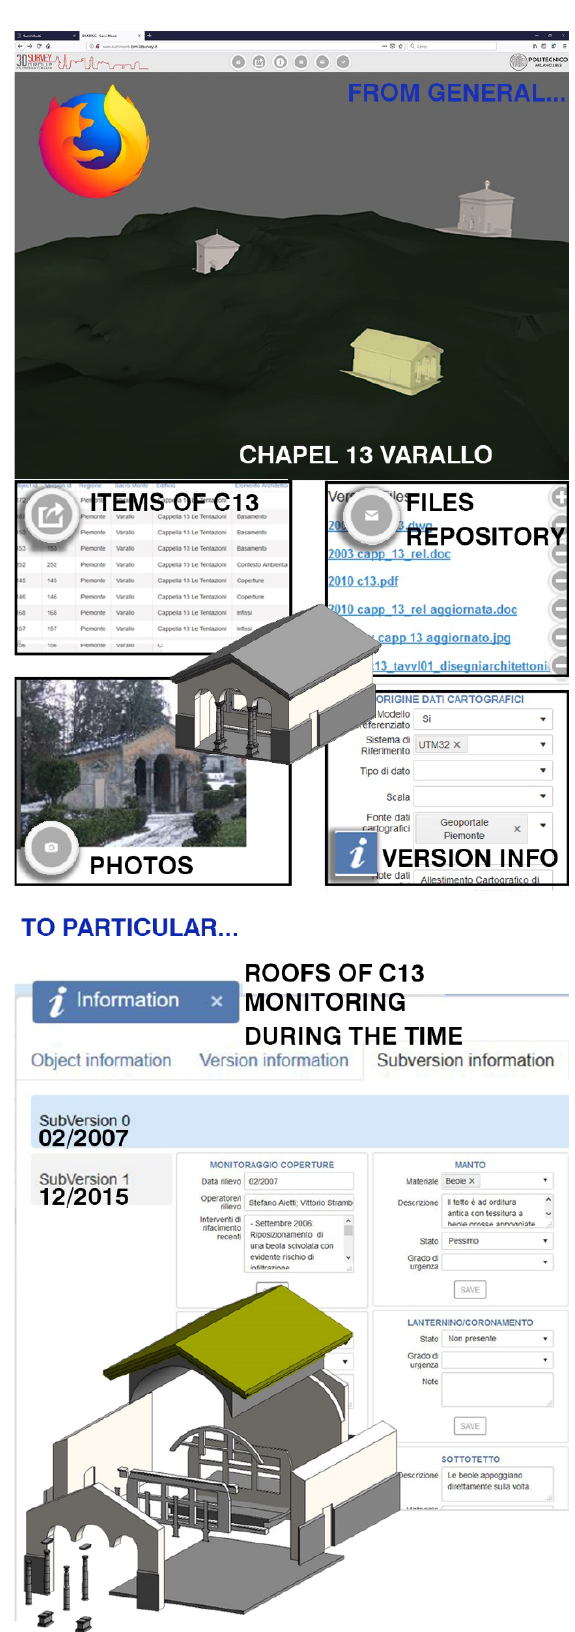
Figure 2. The logic of the system goes from general to particular, connecting a different kind of information to 3D models depending on the category